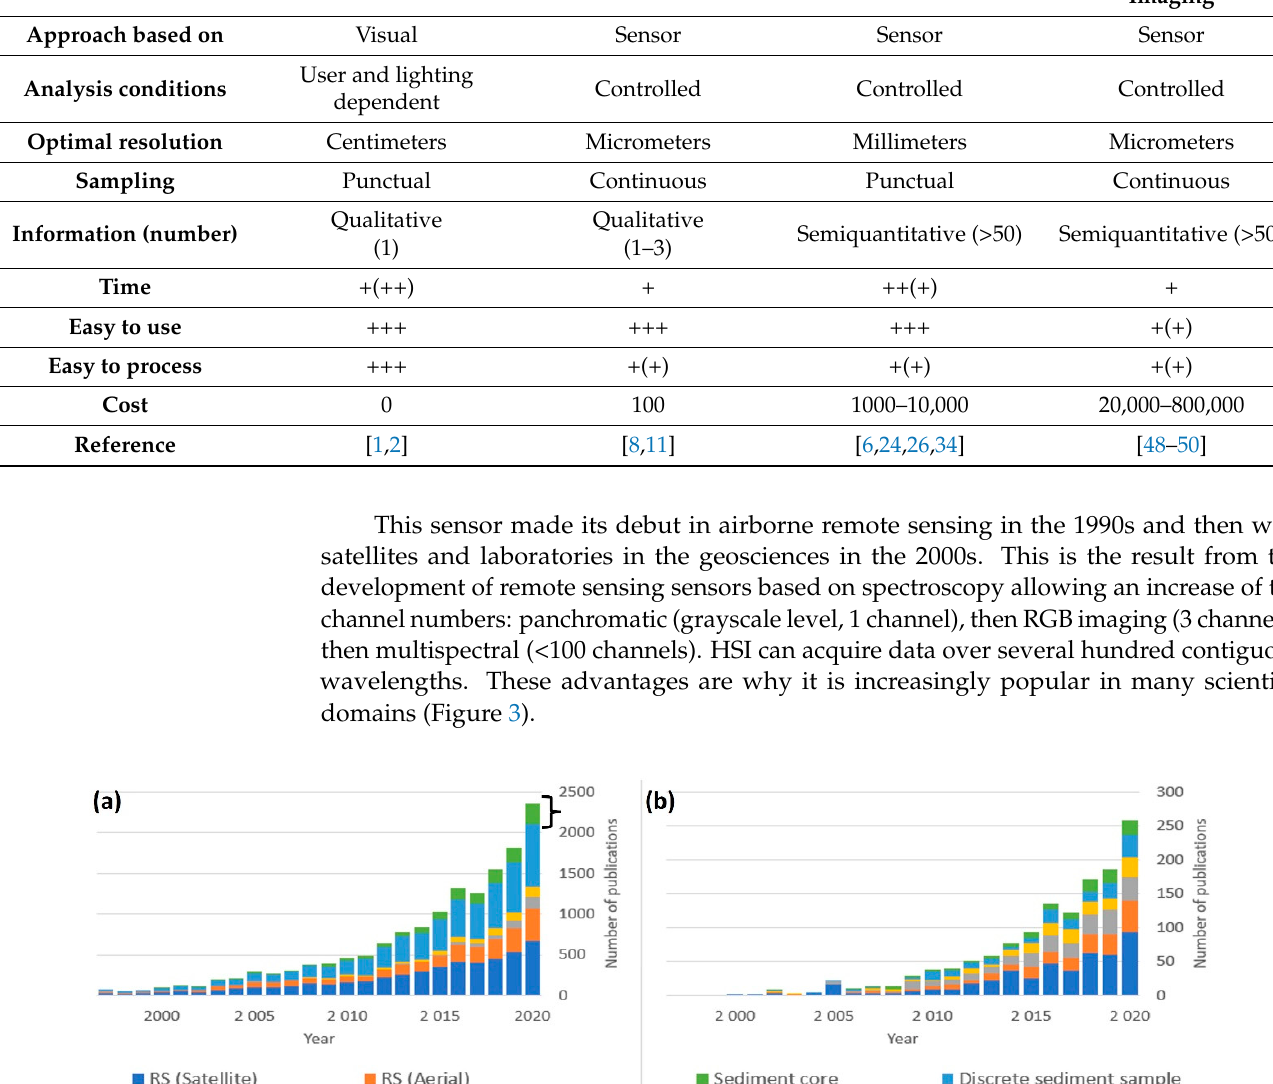
Table 1. Comparison of the technique for the sediment core color analysis.